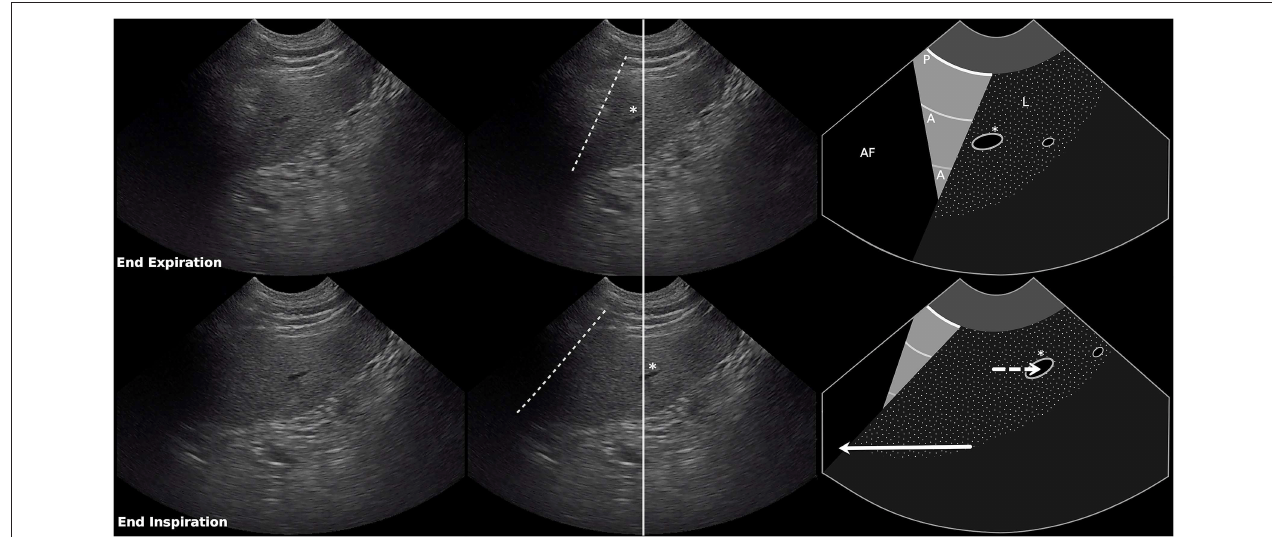
FIGURE 2 | Still images and schematic of an asynchronous curtain sign at end expiration (top row) and end inspiration (bottom row). The ultrasound probe was positioned over the right paralumbar region just below the right kidney, over the liver, between the 9th and 10th intercostal spaces, and incorporates the air/soft tissue interface between the abdomen and the thorax which appears as a vertical edge (curtain sign). During inspiration, the vertical edge of the curtain sign moves in the opposite direction (cranially) of the abdominal contents (caudally). Dashed lines, vertical edge (air/soft tissue interface); Solid line, center of image; RS, rib shadow; P, pleural line; A, A line; L, liver; Asterisk, hepatic vessel. Solid arrow shows direction of movement of the vertical edge during inspiration. Dashed arrow shows direction of movement of the abdominal contents during inspiration. Length of arrow represents degree of movement relative to the image above (also see Video S2 ).